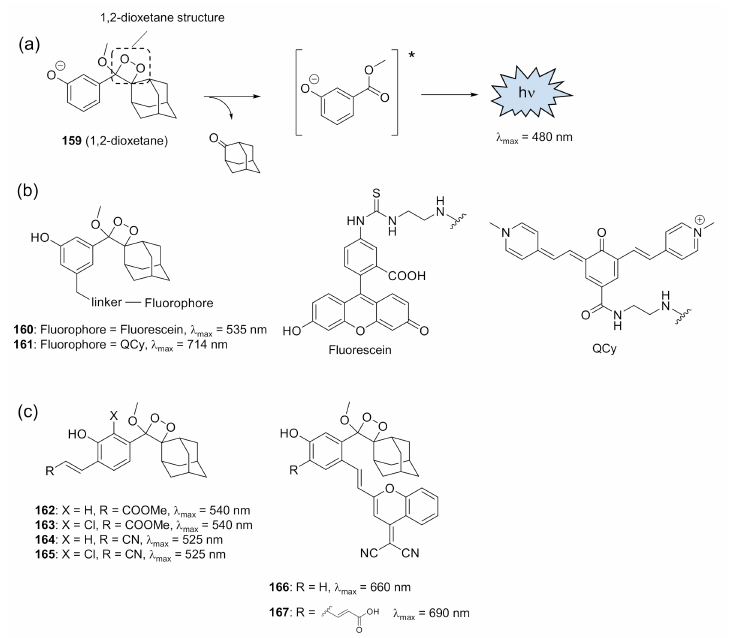
Figure 12. ( a ) Chemiluminescence reaction of 1,2-dioxetane. ( b ) Chemical structures of chemilumi- nescent compounds conjugated with fluorescent dyes. ( c ) Chemical structures of chemiluminescent compounds with high brightness.